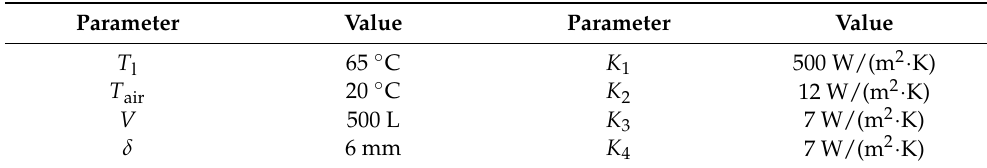
Table 1. Calculation